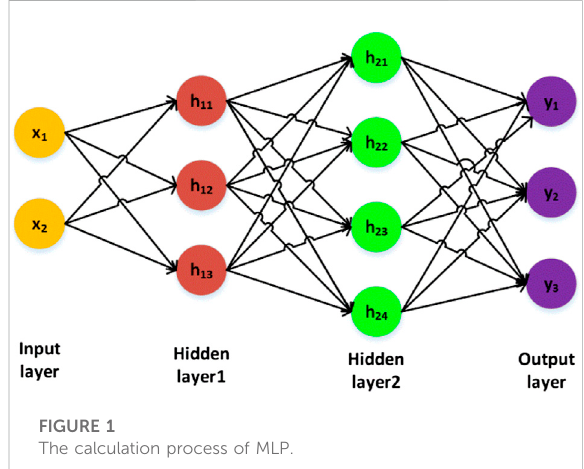
FIGURE 1 The calculation process of